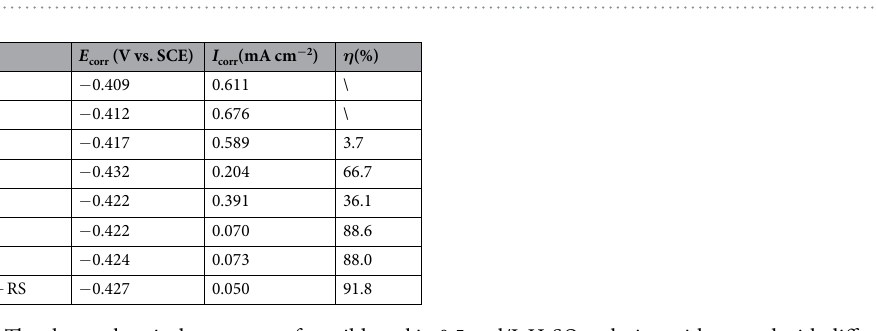
Figure 14. Potentiodynamic polarization curves for mild steel in 0.5 M H 2 SO 4 solution without and with different isolates of LLE at 298